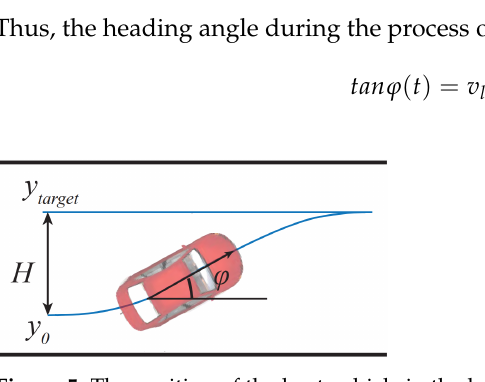
Figure 5. The position of the host vehicle in the lane